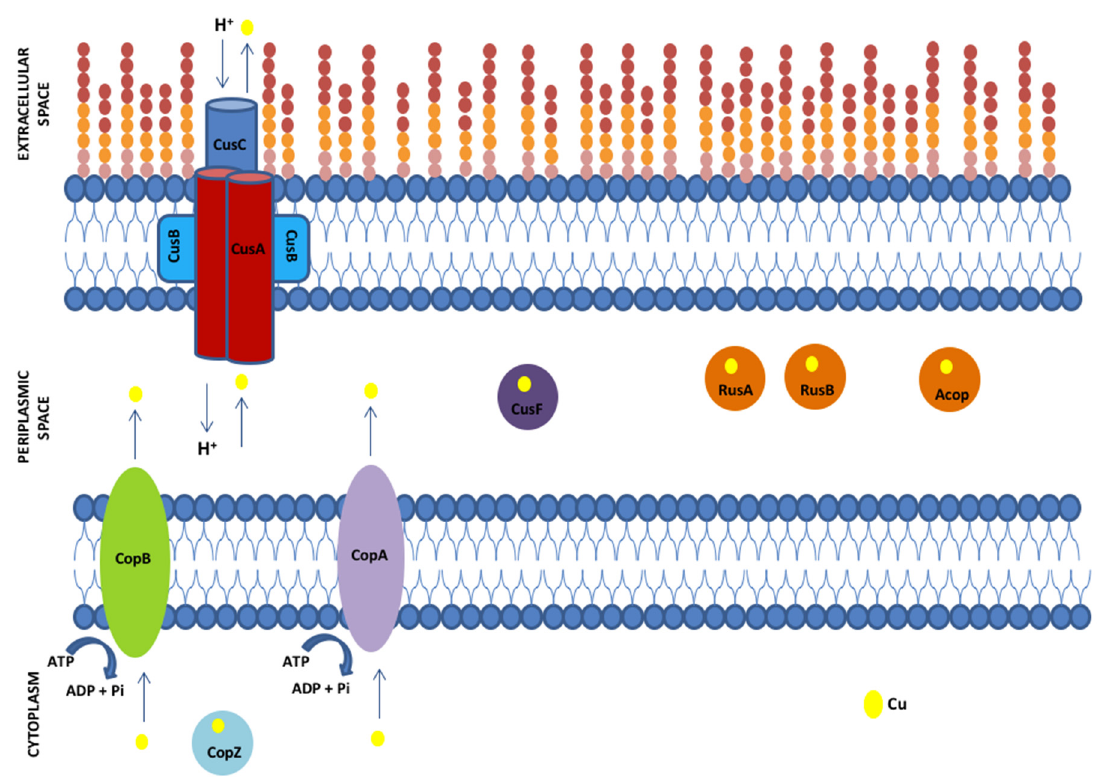
Figure 8. Working scheme showing the identified proteins with potential participation in copper resistance in A. ferrivorans ACH. Proteins: CopZ (metallochaperone), CopA (P-type ATPase pump), CopB (P-type ATPase pump), RusA (rusticyanin A), RusB (rusticyanin B), Acop (cupredoxin), CusF (periplasmic metallochaperone), CusA (inner membrane transporter (RND family)), CusB (periplasmic adaptor factor protein (MFP family)), and CusC (outer membrane factor (OMF)). ATP (adenosine triphosphate), ADP (adenosine diphosphate).